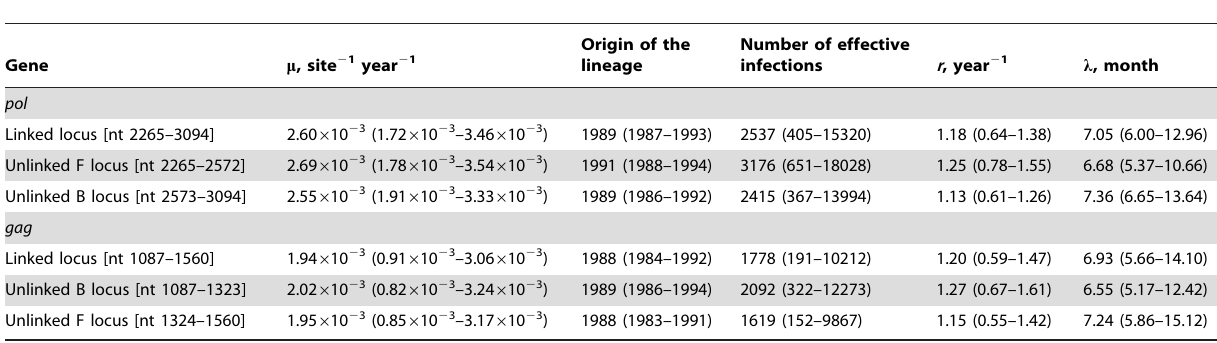
Table 1. Population dynamics estimates for the CRF28/29_BF epidemic.